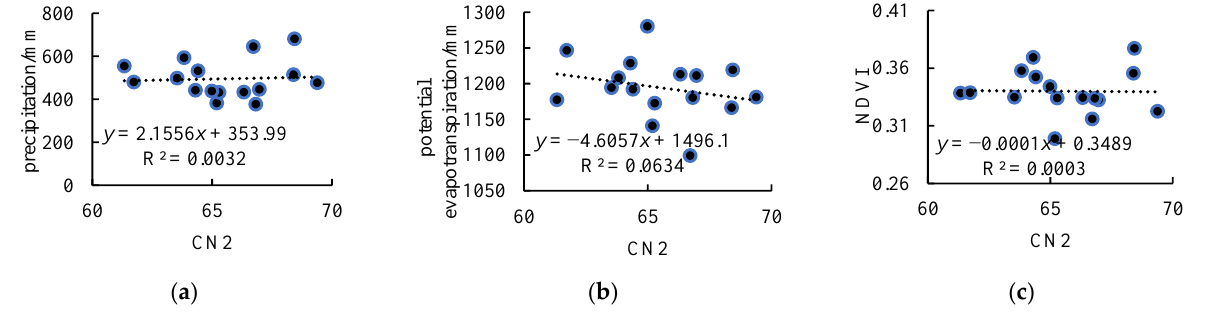
Figure 11. Correlation of CN2 to watershed precipitation, potential evapotranspiration, NDVI. ( a ) Precipitation, ( b ) potential evapotranspiration, ( c ) NDVI.